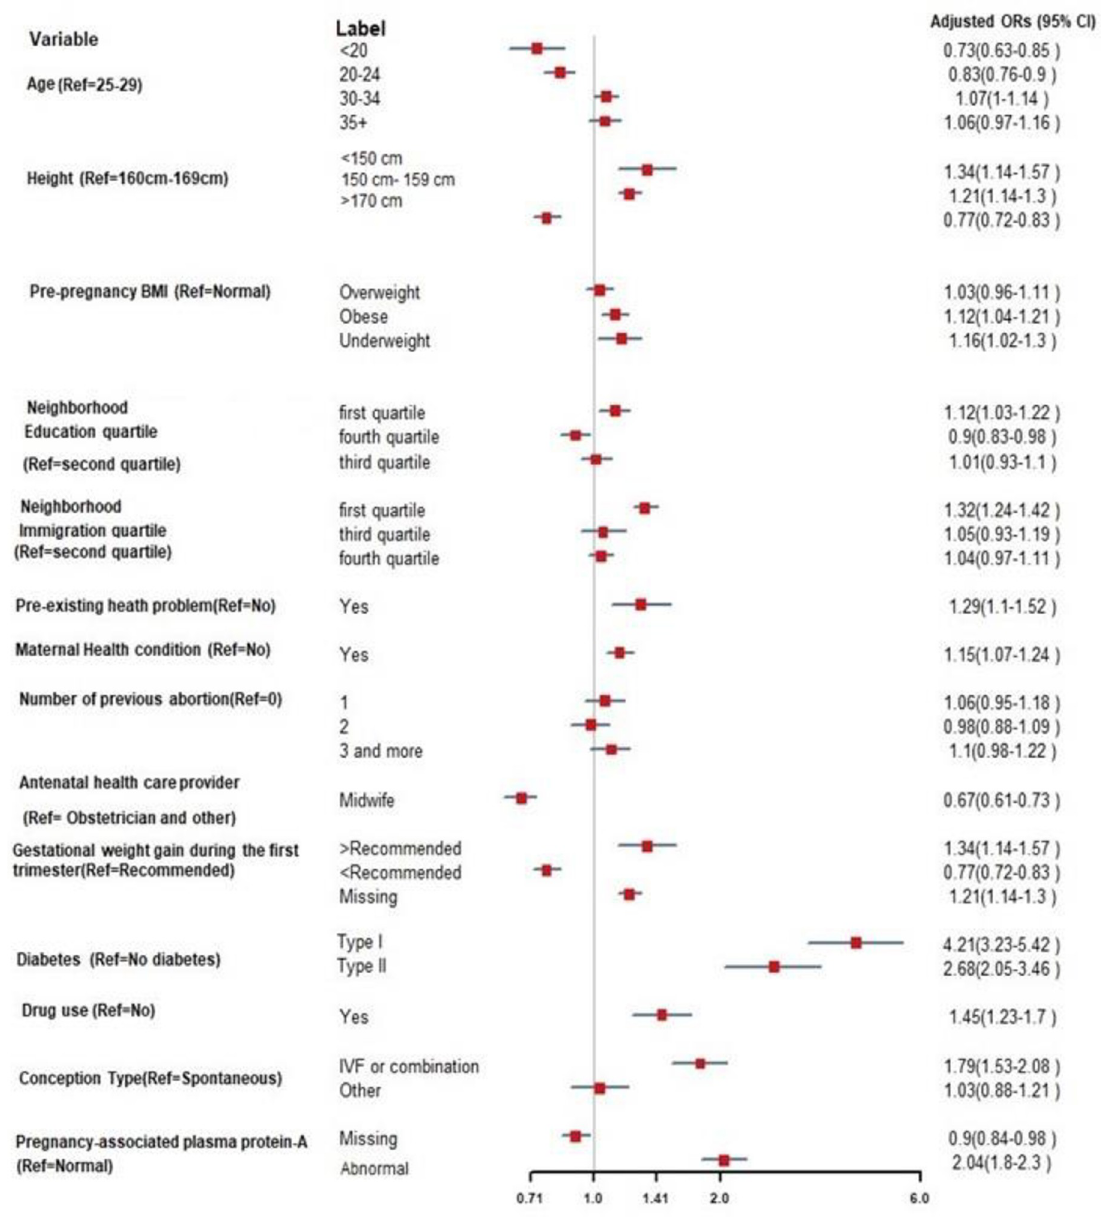
Fig 1. Selected variables and adjusted odds ratios during the first trimester for prediction of preterm birth in nulliparous women. BMI: Body mass index; IVF: In vitro fertilization; Ref: Reference group; Pre-existing maternal health conditions shown in S2 Table. Pre- existing mental health conditions shown in S3 Table. Number of previous abortions: includes the number of miscarriages.